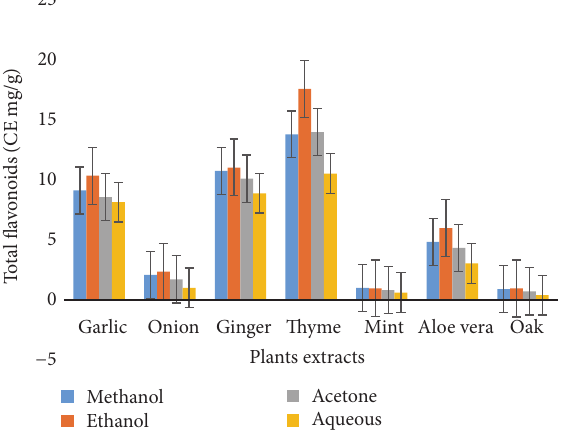
Figure 1: Total phenolic contents.